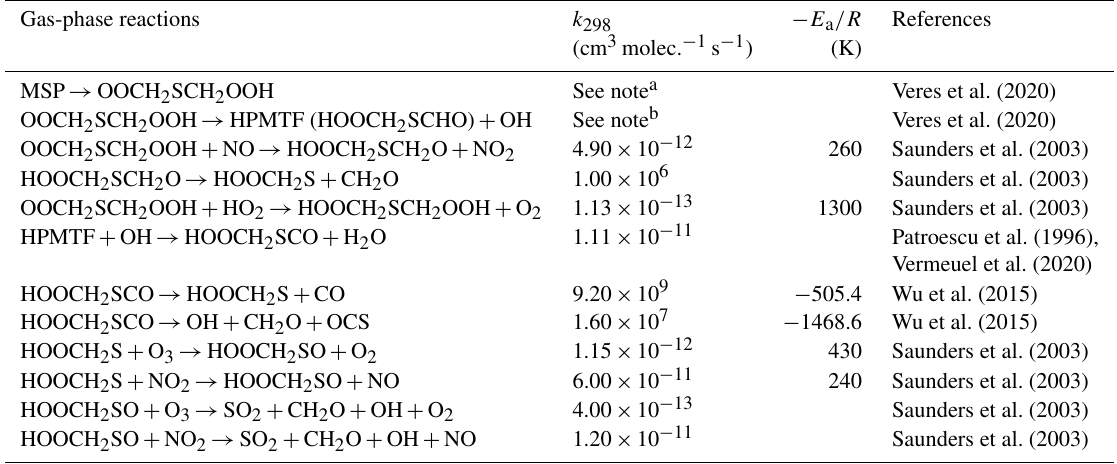
Table 5. Summary of the isomerization branch of the H-abstraction pathway in the DMS chemistry implemented into CAM6-chem. Gas-phase reactions